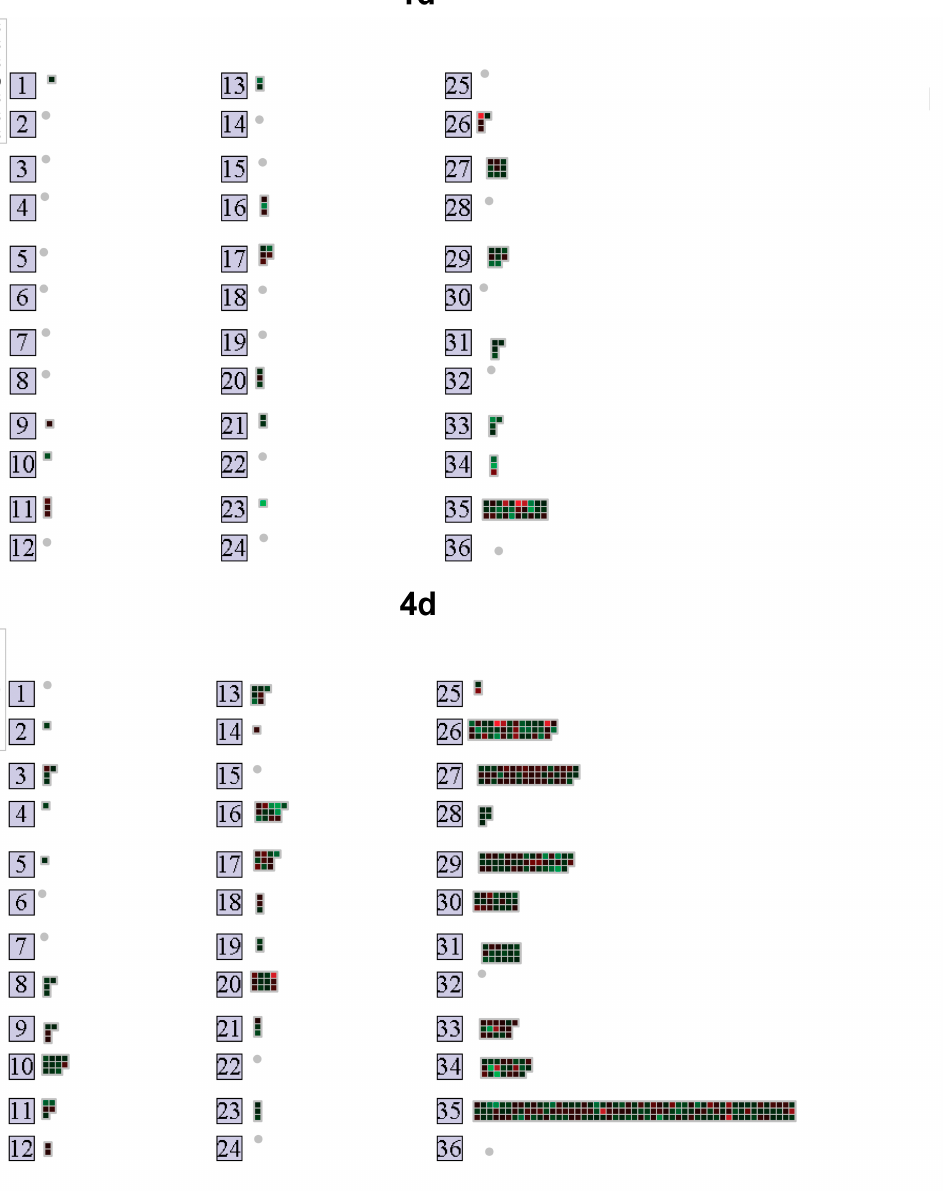
Figure 3. Overview of transcripts specifically modulated in T250 roots at 1 d and 4 d according to MapMan bincode classification. Log 2 (ratio) is shown by the color scale (green indicates a decrease and red an increase in transcript abundance in the comparisons 1 d vs. 0 d and 4 d vs. 0 d). Colored square: modulate transcript; gray circle: category without modulated